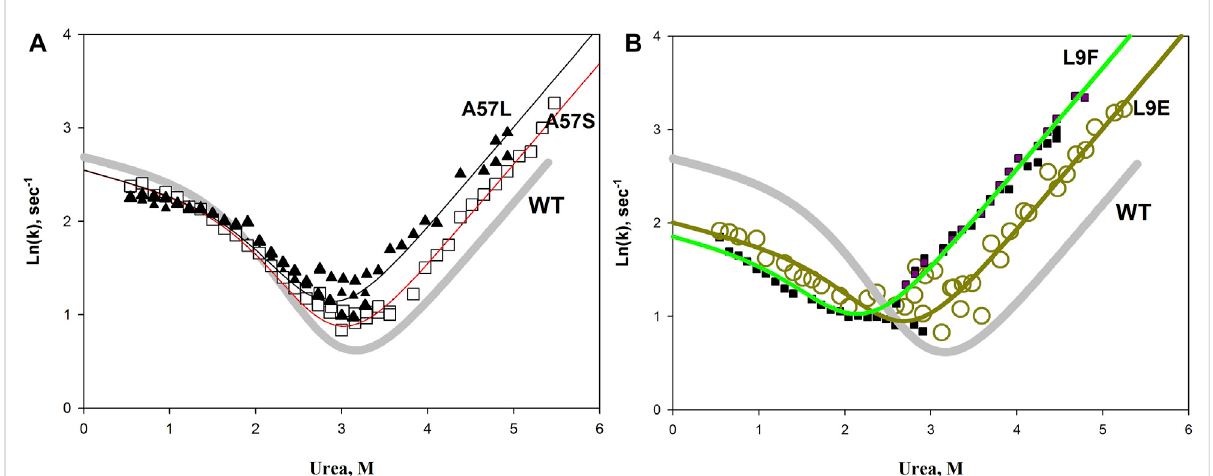
FIGURE 9 Chevronplotsofwild-type apomyoglobin(thickgrayline)andproteinswithA57L,A57Ssubstitutions (A) ,andL9FL9Esubstitutions (B) .Symbols show experimental data, lines show approximations according to the three-state